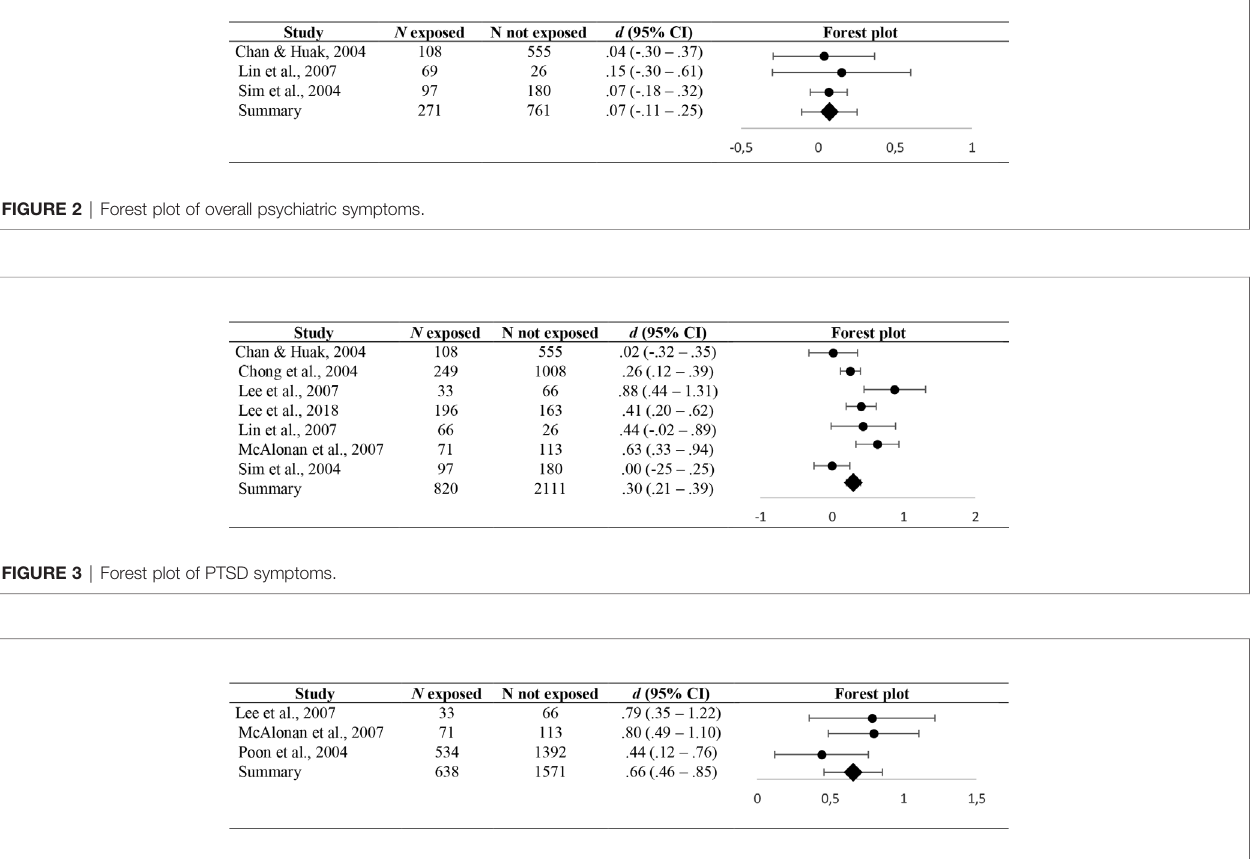
FIGURE 4 | Forest plot of depression and anxious